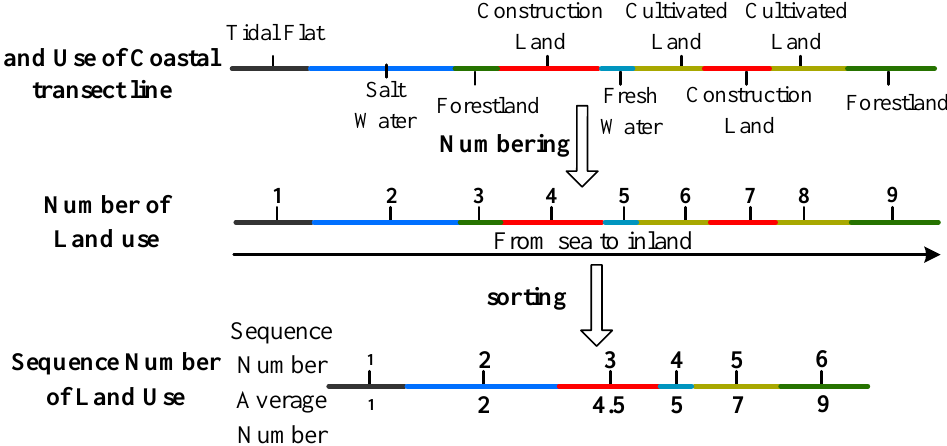
Figure 3. The process of numbering the land-use types in one line.